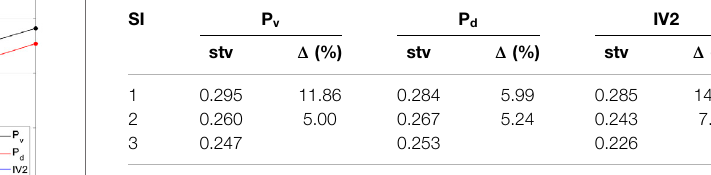
TABLE 9 | Comparison of the standard deviation stv between the leading 3 parameters for estimating